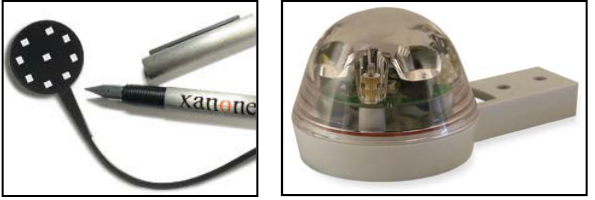
Fig. 2. Optical sensors, left: Xanonex, and right: Hydreon (Hydreon, 2012; Xanonex, 2012). Figure 2. Optical sensors, left: Xanonex, and right: Hydreon (Hydreon, 2012;Xanonex, 2012) 2